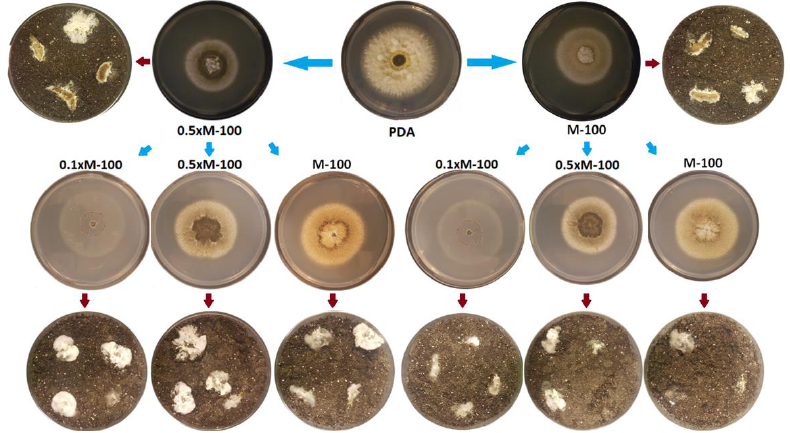
Figure 3. Three examples of a theoretic model relating to energetic cost of mycelial density to probability of an encounter of those mycelia with an insect or plant host. The model assumes that the cost is proportional to the total volume of the mycelia (blue line) while the probability of encounter assumes the volume of those hyphae relative to a sphere with a radius equal to the maximum length of a hypha (orange line). Shown are three examples where the mycelial density is ( A ) Low density (“sleeper”), ( B ) Medium density (mixed strategy), and ( C ) High density (“creeper”). Note that scales of the energetic cost in the three graphs are different and that there is a relatively lower metabolic cost associated with low density.